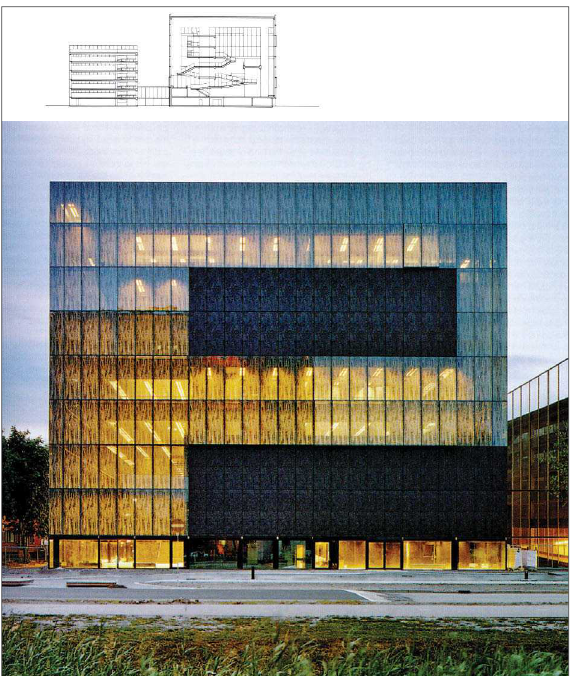
8 pav. Utrechto universiteto biblioteka Olandijoje (2005 m.) Fig 8. Utrecht University Library in Holland (2005)